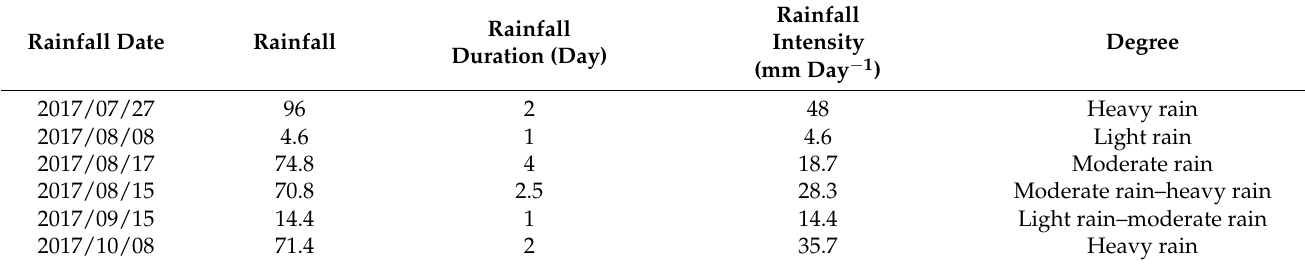
Table 3. Rainfall characteristics and rainfall degree.